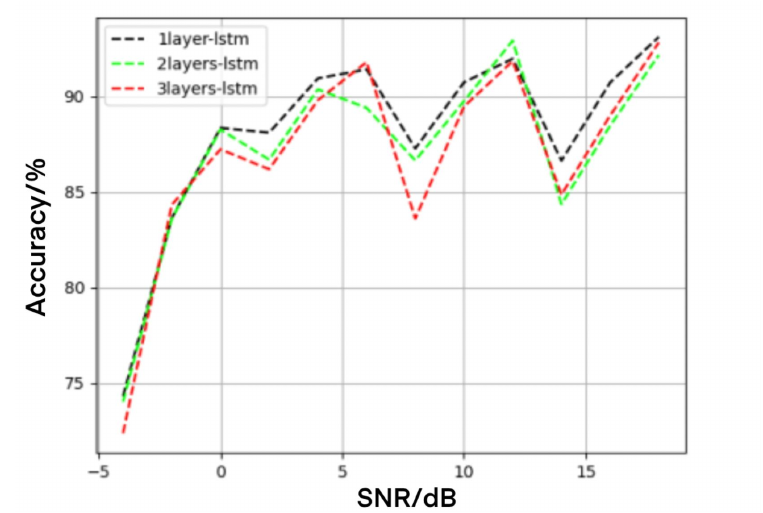
Figure 8. Effect of different LSTM layers on recognition rate.